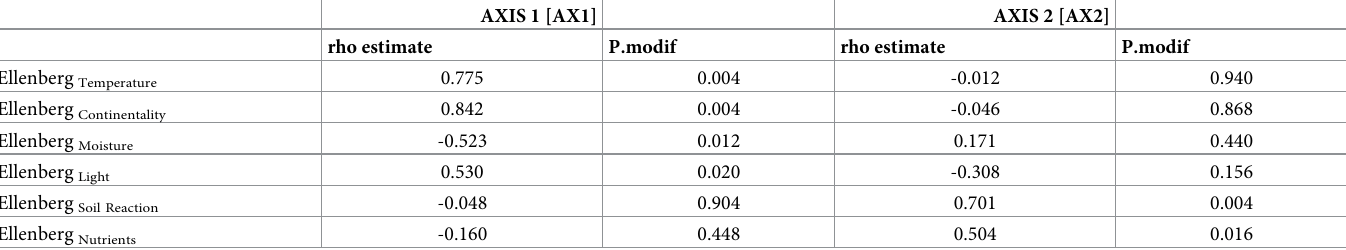
Table 1. Significance of Spearman’s rank correlation of mean Ellenberg’s indicator values (EIVs) with two main DCA axes within rocky scrub communities of Cen- tral Europe. The statistical significance of correlation between studied plots and the EIVs is expressed by the p –values based on modified permutation test